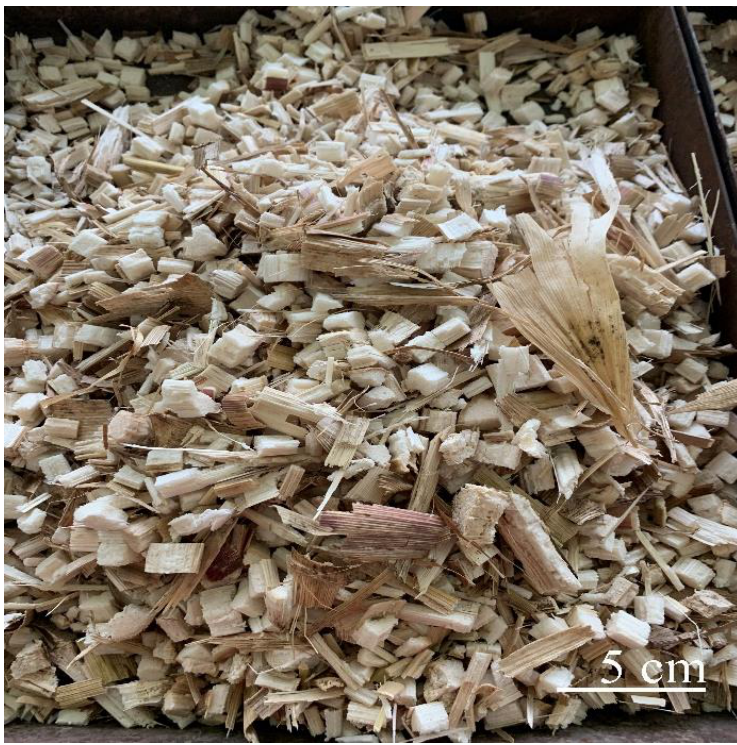
Figure 1. Crushed corn stover pellets. Table 2. Main components of corn straw.